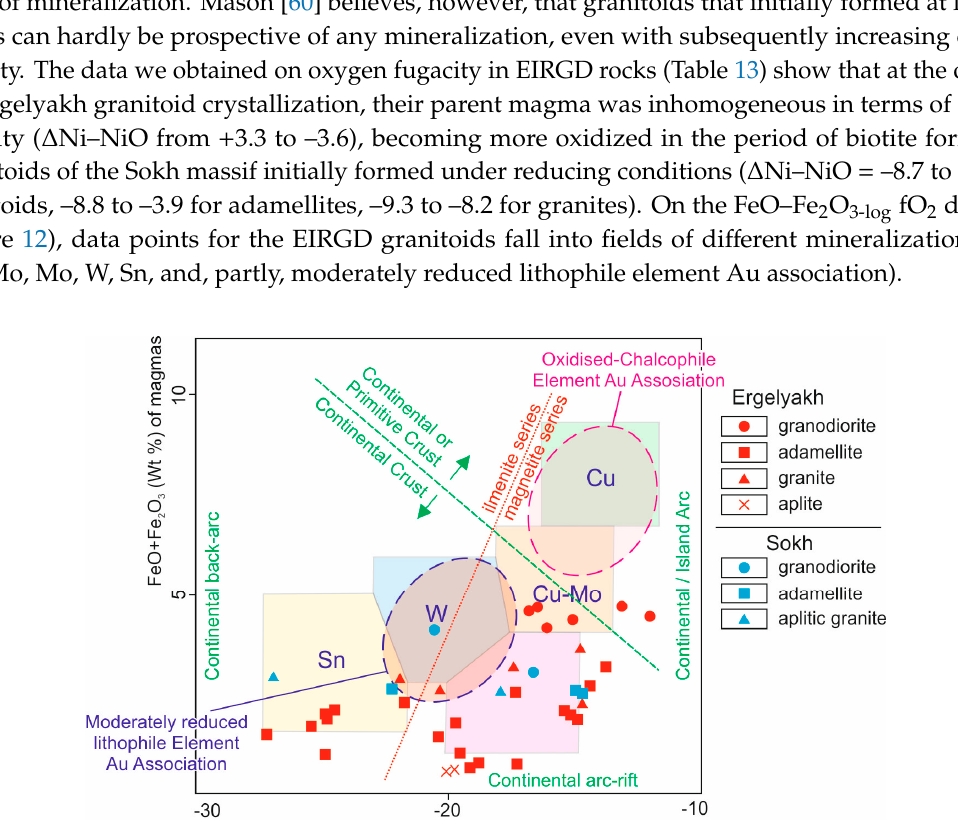
Figure 12. Schematic diagram of relationship between fractionation degree and oxidation state of magma and dominant metal paragenesis with reference to granitoids of Ergelyakh and Sokh massifs [11]. Data points for biotites on the IV(F / Cl)–IV(F) diagram are plotted into the field of rocks promising for Sn–W–Be and Cu–porphyry mineralization (Figure 13). While schematic, the discrimination diagrams presented here well illustrate the mineragenic specialties of the